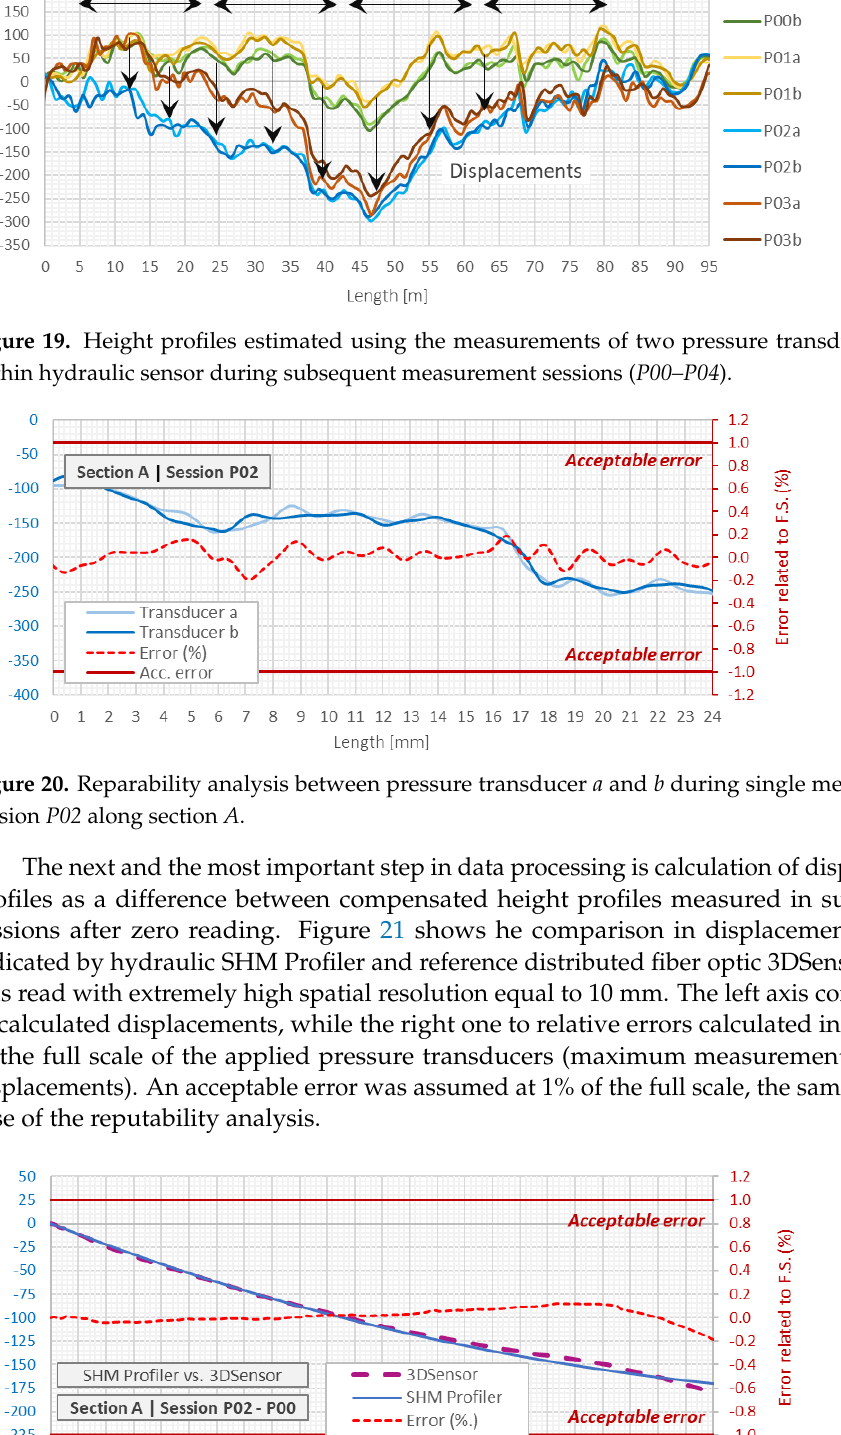
Figure 19. Height profiles estimated using the measurements of two pressure transducers ( a, b ) within hydraulic sensor during subsequent measurement sessions ( P00–P04 ).